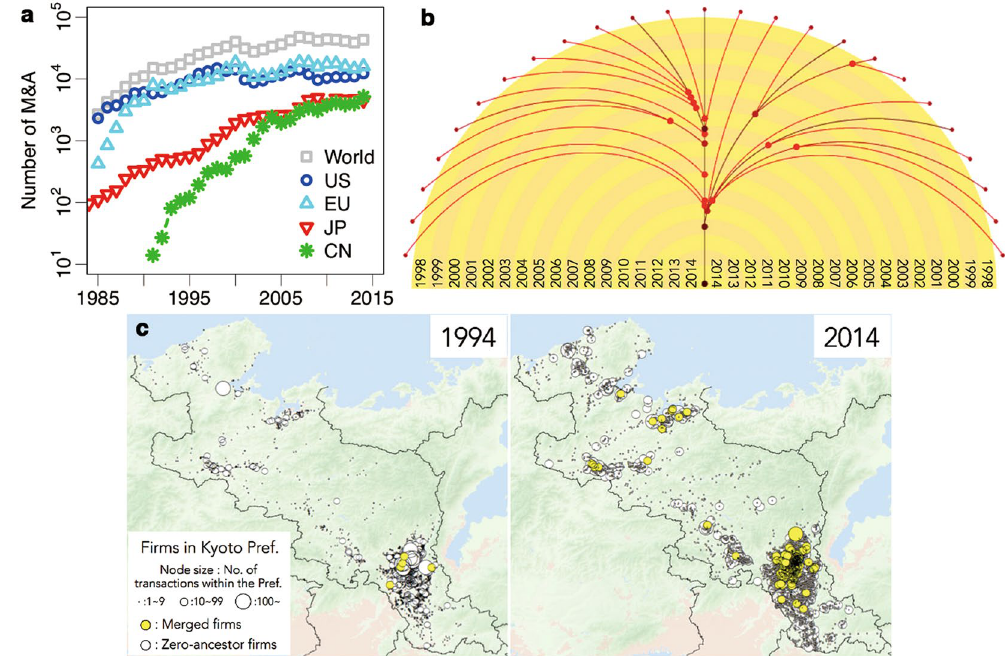
Figure 1. Increasing of M&A activities. ( a ) Change of the annual number of mergers and acquisitions on a semilog scale. Each plot shows the evolution in numbers of M&A for the whole world (gray), US (blue), EU (light-blue), JP(red) since 1985 (red), and CN since 1988 (green). ( b ) An illustrative example of an actual firm merger history diagram (Generated by MATLAB 8.5 software 30 ). Each node within the colored region relates to a single company merger within the year indicated by the corresponding semi circled color strip, whereas those out of the boundary represents each single company prior to 1998. Each arched line represents the period of existence of a given company since 1998,whereas the central vertical line corresponds to the surviving company. ( c ) Spatial distribution of firms that are sized by number of transaction partners within Kyoto Prefecture in 1994 (left) and in 2014 (right) (Generated by Arc GIS 10.2 software 31 ). Yellow and white nodes are firms that have merged or not, respectively. In addition, the larger the number of transaction partners a firm has, the bigger the radius of